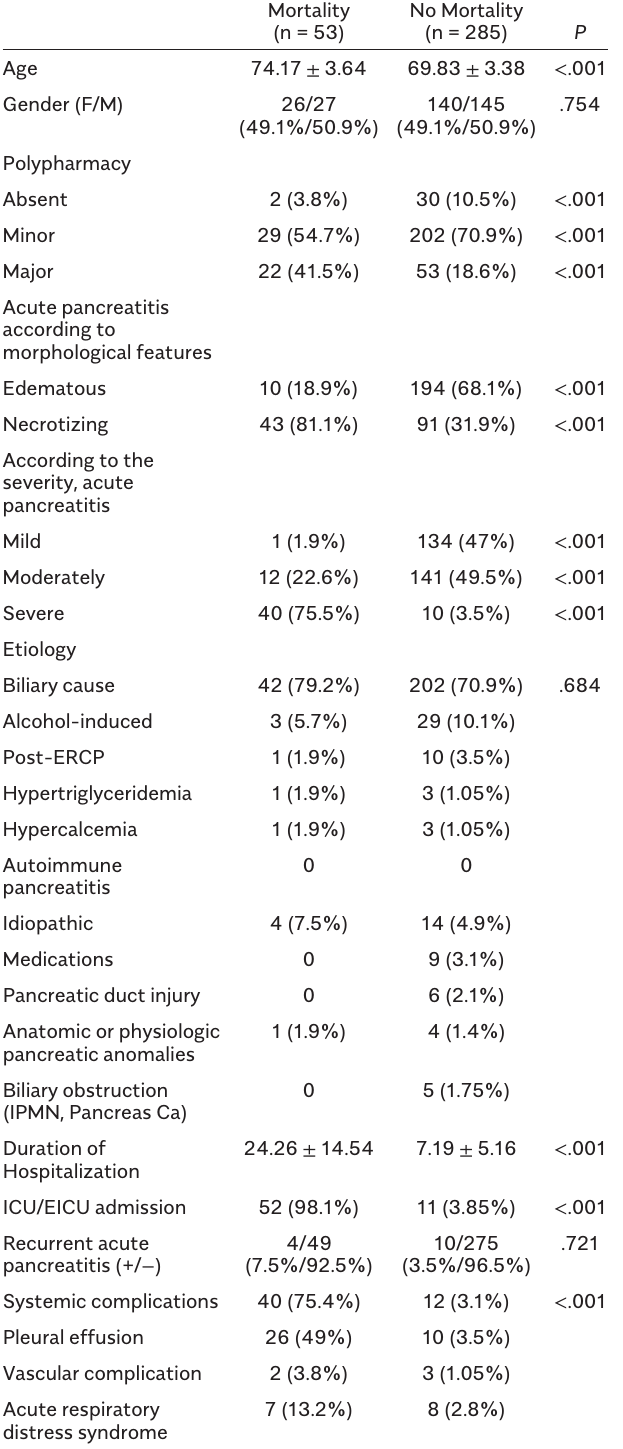
Table 2. Differences Between Patients aged 65-80 Years with and without Mortality ( Continued